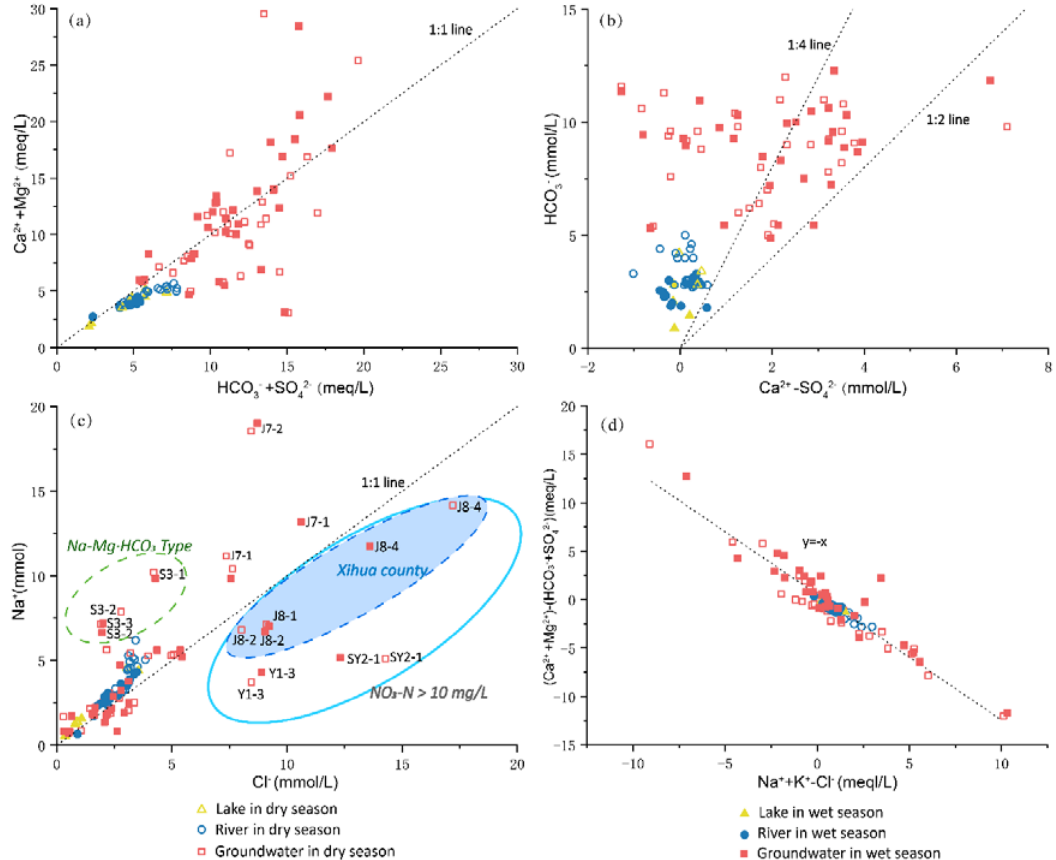
Figure 12. The diagram of the co-variation between main chemical components. ( a ) Ca 2 + + Mg 2 + vs. HCO 3 − + SO 42 − . ( b ) HCO 3 − vs. Ca 2 + -SO 42 − . ( c ) Na + vs. Cl − . ( d ) (Ca 2 + + Mg 2 + )–(HCO 3 − + SO 42 − ) vs. Na + + K + -Cl −